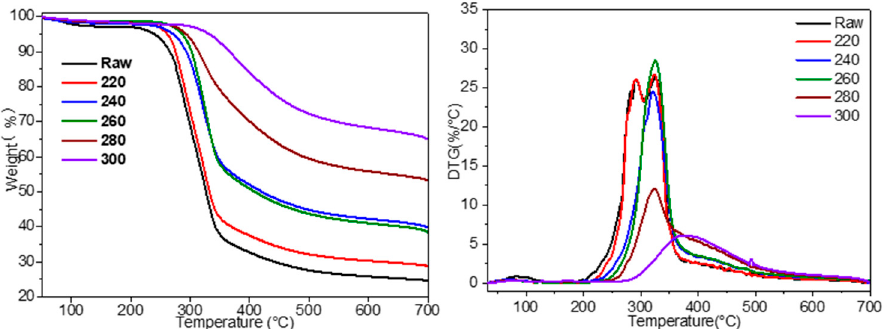
Figure 3. The TG/DTG curves for pyrolysis of raw and torrefied corn cobs. As shown in Table 2, the pyrolysis reactivity of torrefied corncob is quantitatively described by the comprehensive pyrolysis index (CPI) [27]. When the torrefaction temper- ature increases, the CPI of torrefied corn cobs first increases and reaches the maximum value at 260 °C. The enhancement in the pyrolysis reactivity of corn cobs is attributed to the increase in the percentage of cellulose in torrefied corn cobs as a result of the more severe decomposition of hemicellulose due to torrefaction. As the torrefaction temperat- ure further increases from 260 to 300 °C, the CPI of torrefied corn cobs decreases conside- rably, owing to the severe depolymerization of cellulose and the polycondensation/carb- onization of hemicellulose/lignin during the torrefaction of corn cobs at this temperature. Therefore, for effective pretreatment prior to biomass pyrolysis, the torrefaction temperat- ure should be not higher than 260 °C. A higher torrefaction temperature could cause sev- ere devolatilization, polycondensation, and carbonization of biomass, resulting in a cons- iderable reduction in the pyrolysis reactivity and resulting liquid yield. Table 2. The pyrolysis characteristic parameters obtained from the TG/DTG curves for pyrolysis of raw and torrefied corn cobs. Feedstock